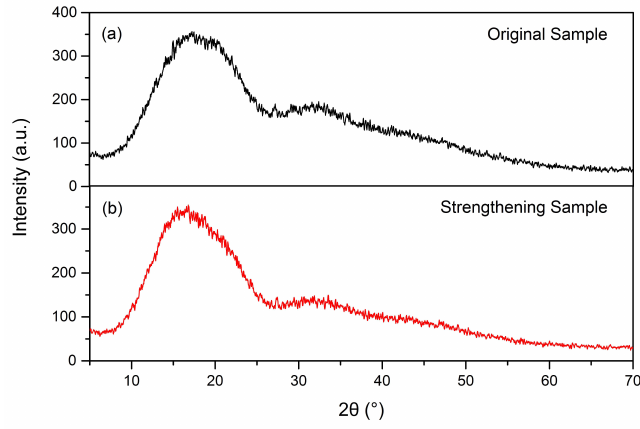
Figure 7. XRD patterns of the original ( a ) and ultrasonic-strengthened ( b ) PLA samples.